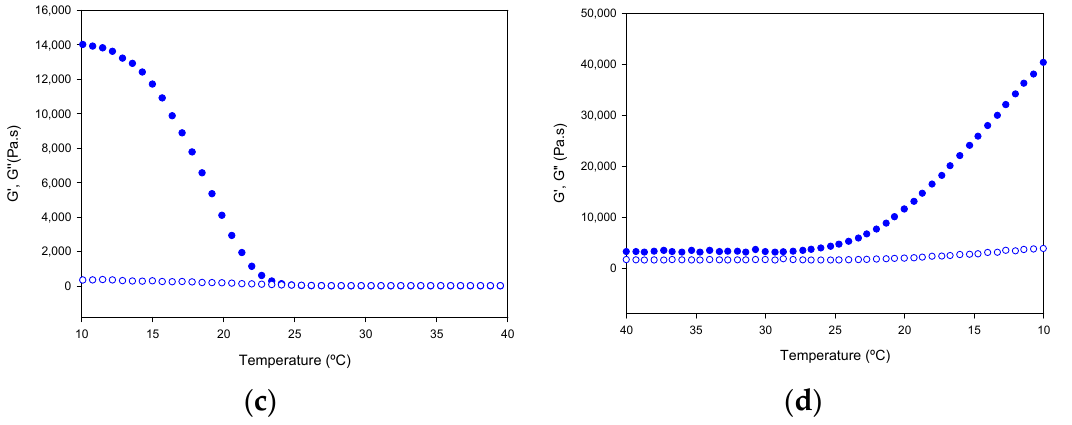
Figure 13. Variation of complex viscosity ( a , b ); and storage modulus (G’, filled circle) and loss